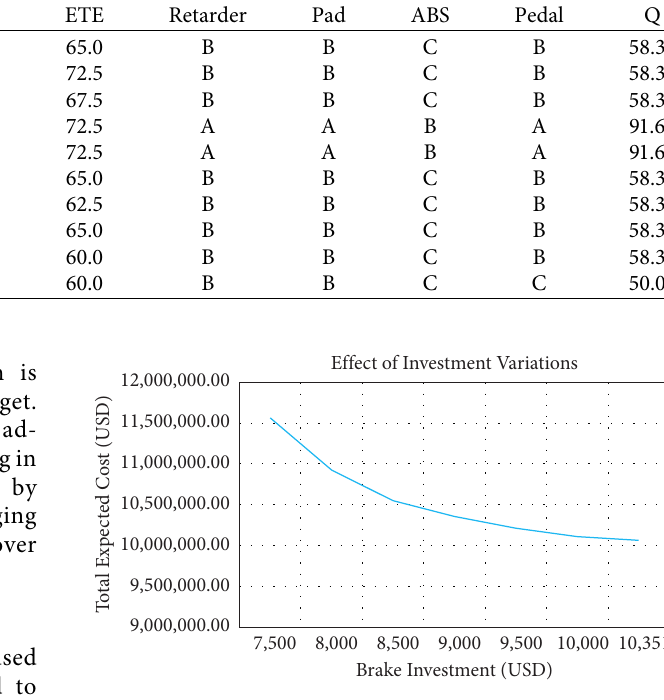
Figure 2: Brake investment sensitivity